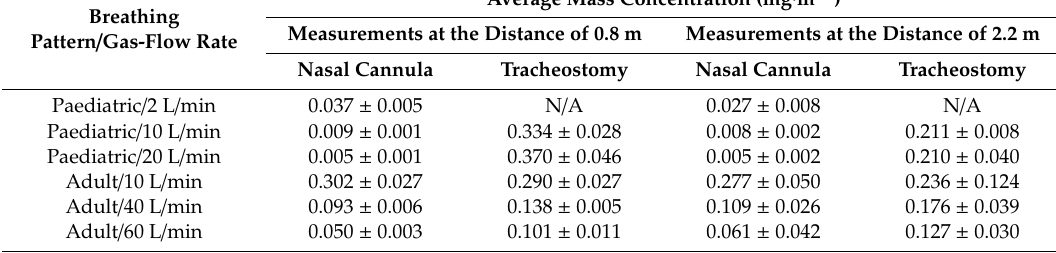
Table 3. The 30-min averaged mass concentration at a distance of 0.8 m and 2.2 m for the adult and paediatric scenarios using the nasal cannula and tracheostomy interfaces, mean and standard deviations over the three events.